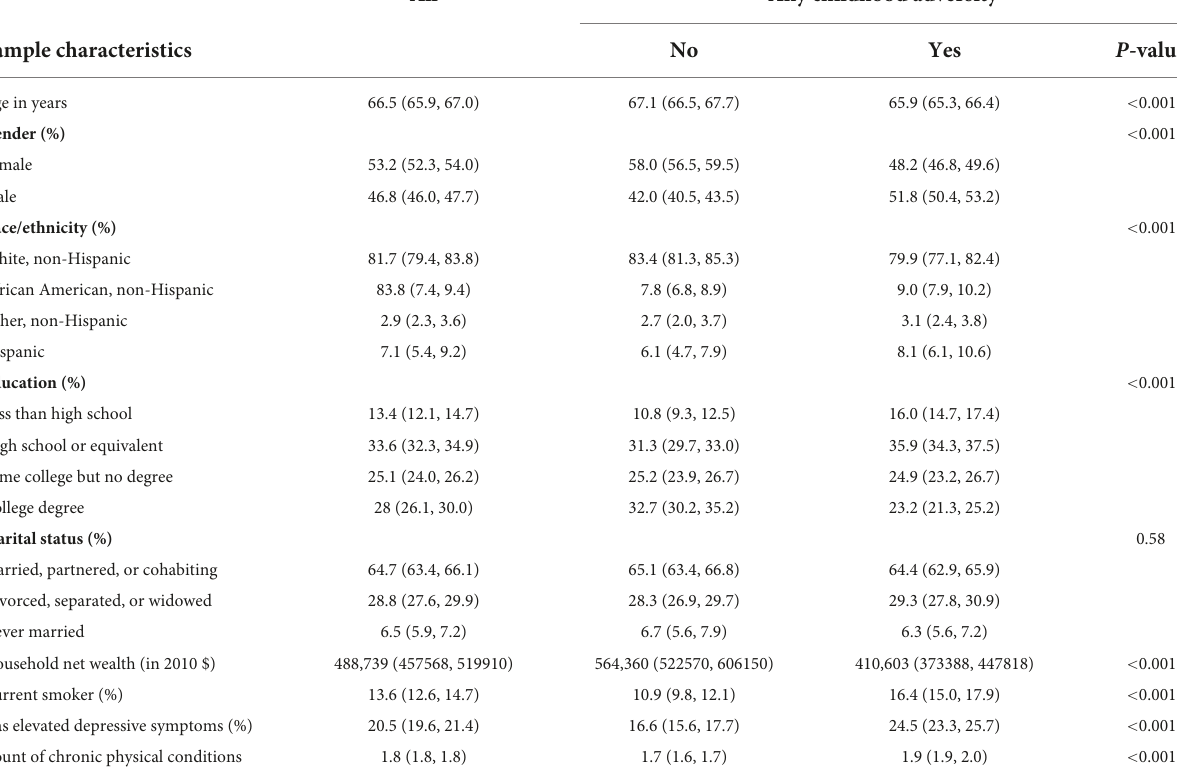
TABLE 1 Descriptive statistics of the study sample in 2010 stratified by childhood adversity status.